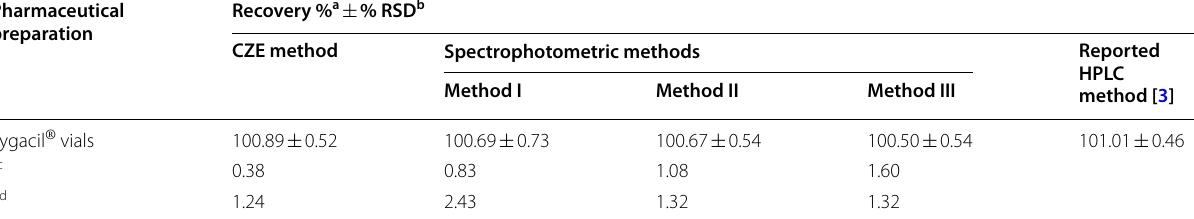
a Average of three determinations bRelative standard deviation c Represents calculated values of t d Represents calculated values of F